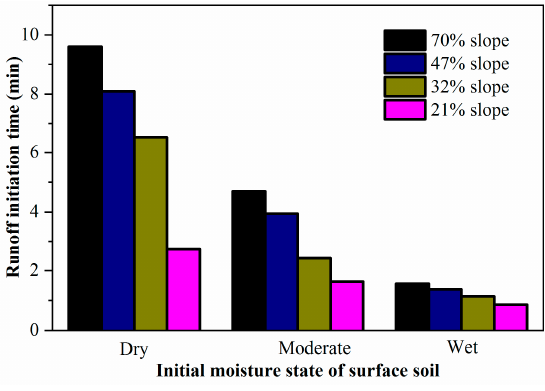
Figure 5. Runoff initiation time of each slope under different initial soil water contents. Figure 5. Runo ff initiation time of each slope under di ff erent initial soil water